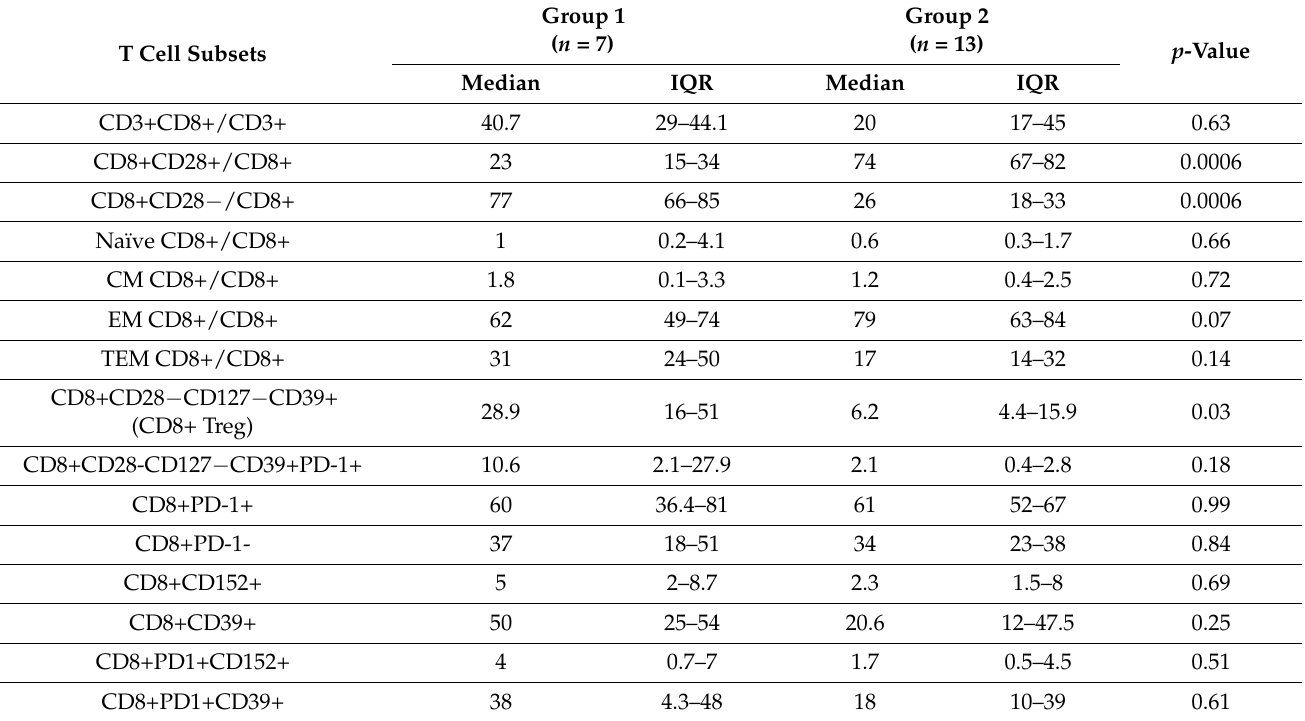
Table 3. Percent frequencies of HNSCC infiltrating CD8+ T cell subsets in Group 1 and Group 2.